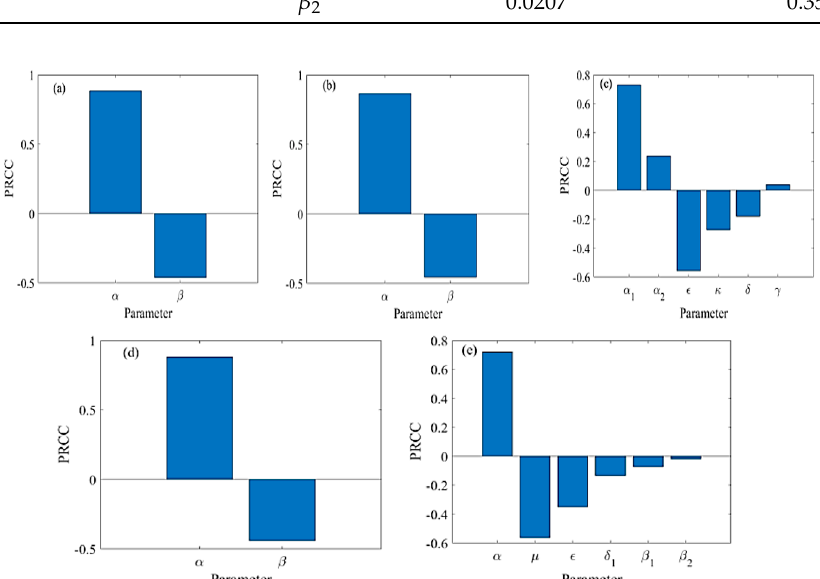
Figure 4. The values of AICc, BIC, RMSE, and R from 22 January to different end times in Beijing.